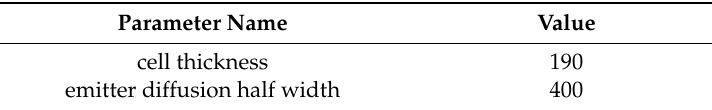
Figure 1. Cross-section of FFE IBC solar cells. The dashed box indicates the unit cells used in the device simulations. Table 1. Parameters used in this simulation